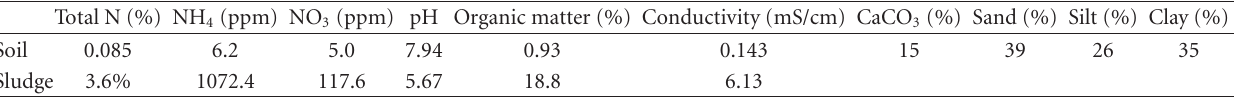
Table 1: Some physical and chemical properties of the soil in the experimental site and the incorporated sewage